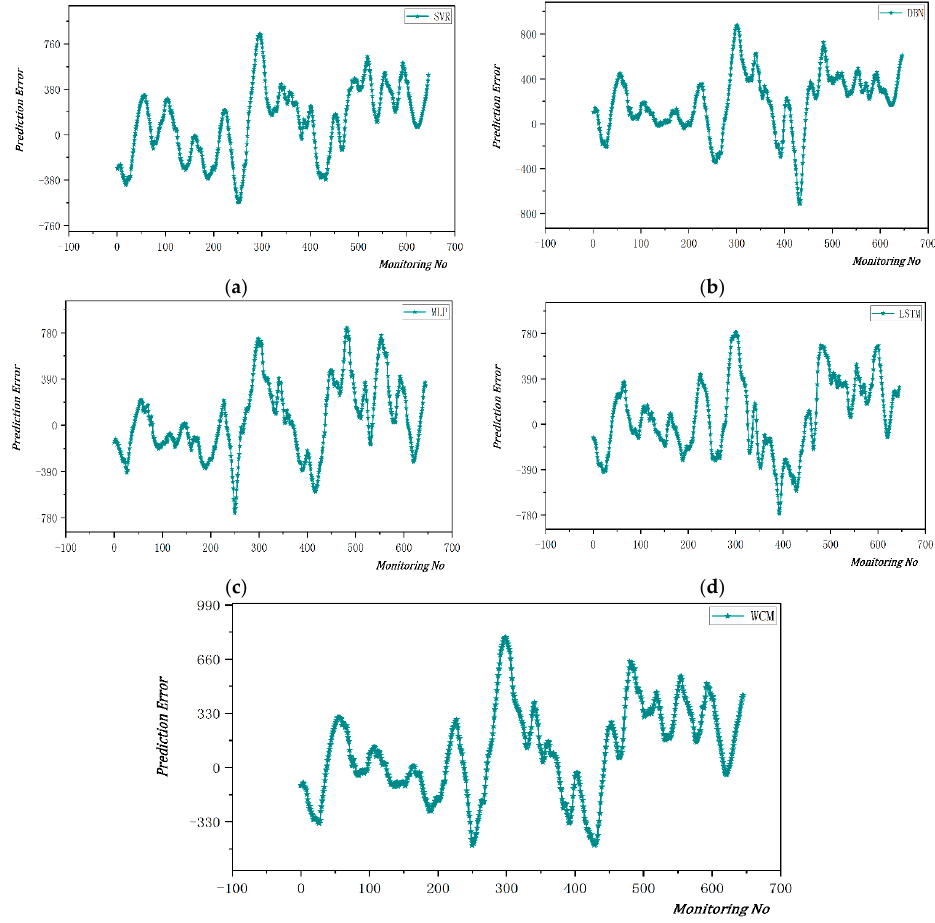
Figure 9. Prediction error analysis. ( a ) SVR. ( b ) DBN. ( c ) MLP. ( d ) LSTM. ( e ) WCM.